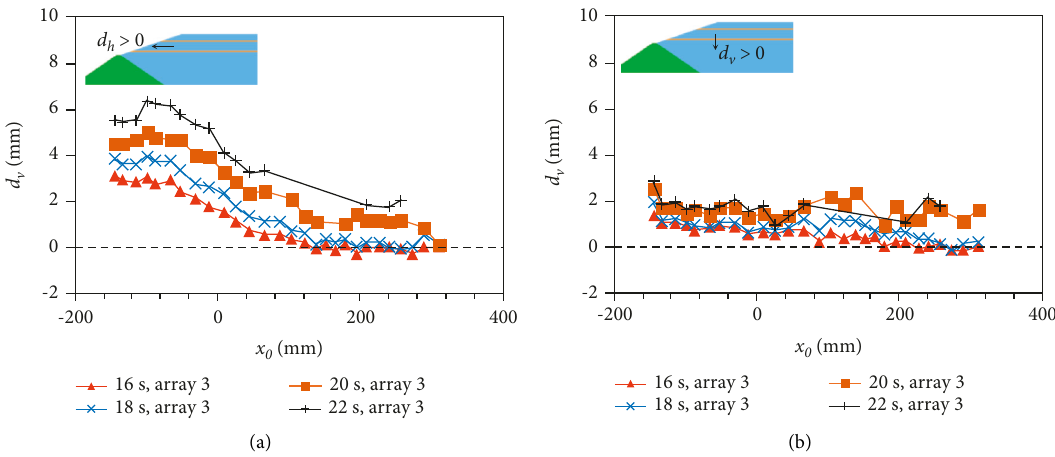
Figure 15: Horizontal distributions of (a) horizontal and (b) vertical displacements of the trace markers in array 3 above the relatively deep silty layer in stage 3.